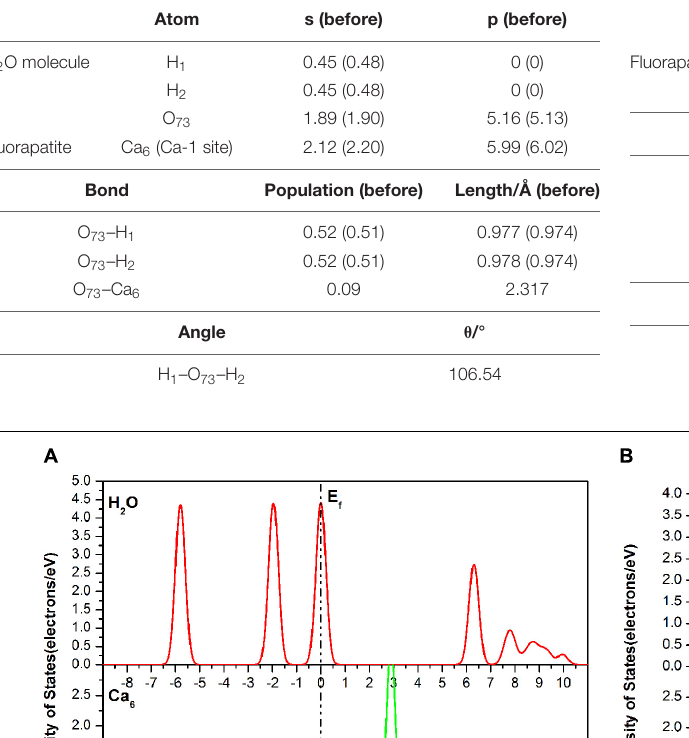
TABLE 2 | Charge transfer and bond properties of the double-site adsorption.